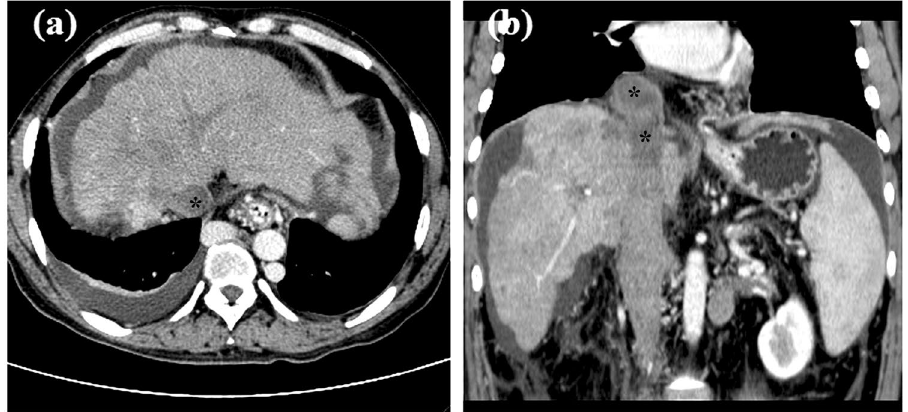
Figure 1. Preoperative CT scanning. ( a ) Liver cirrhosis caused by BCS, hydrothorax, and can be seen in the cross section of CT. ( b ) Segmental occlusion of IVC with thrombus was shown in coronal section view. * indicated